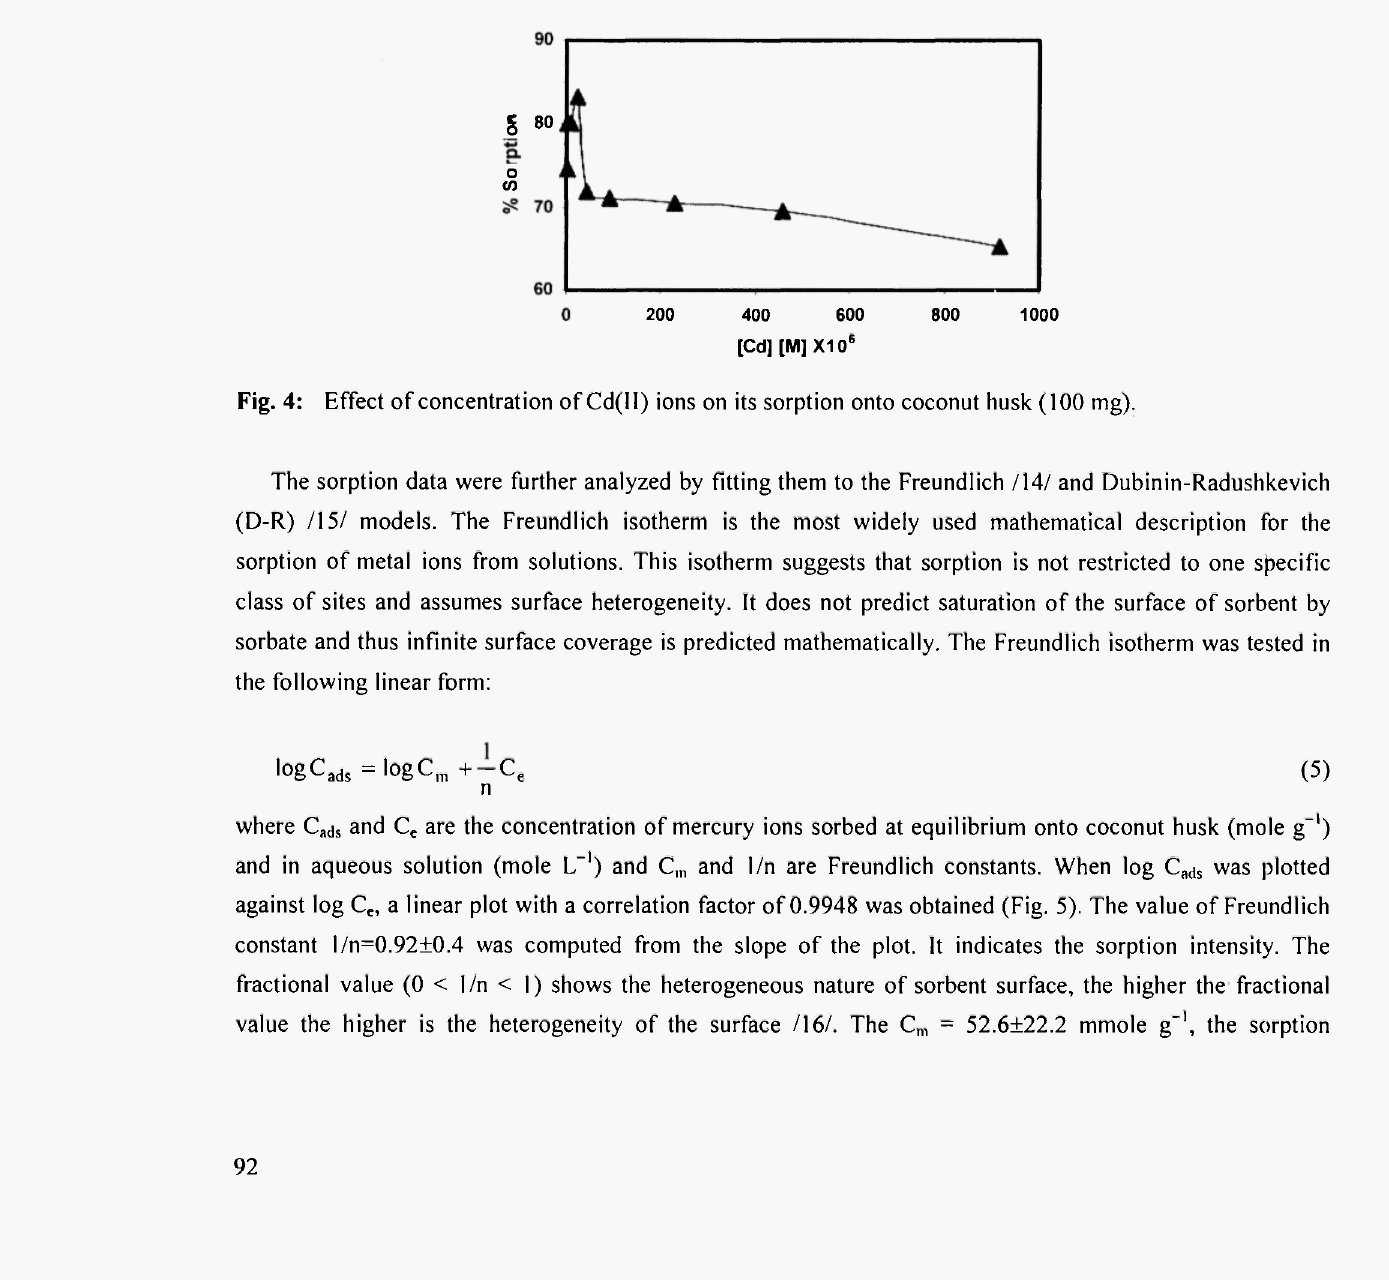
Fig. 3: Sorbed concentration of Cd(II) (2.29 χ 10~ 5 M) onto coconut husk (100 mg) as a function of shaking time.